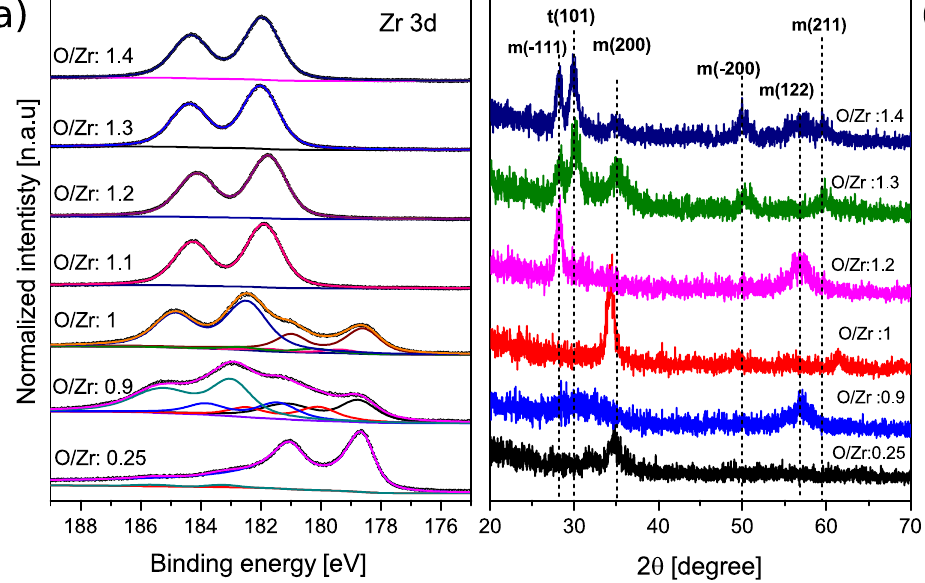
Figure 3. ( a ) Core level Zr3d spectra (XPS) for bulky ( ≥ 80 nm) films corrected using MNV reference. The colored lines are the different components. The open circles are the spectrum data points after background subtraction. The solid line behind the open circles is the fit sum of the components. ( b ) XRD spectra of several deposited film with different stoichiometry (t for tetragonal phase, m for Methods